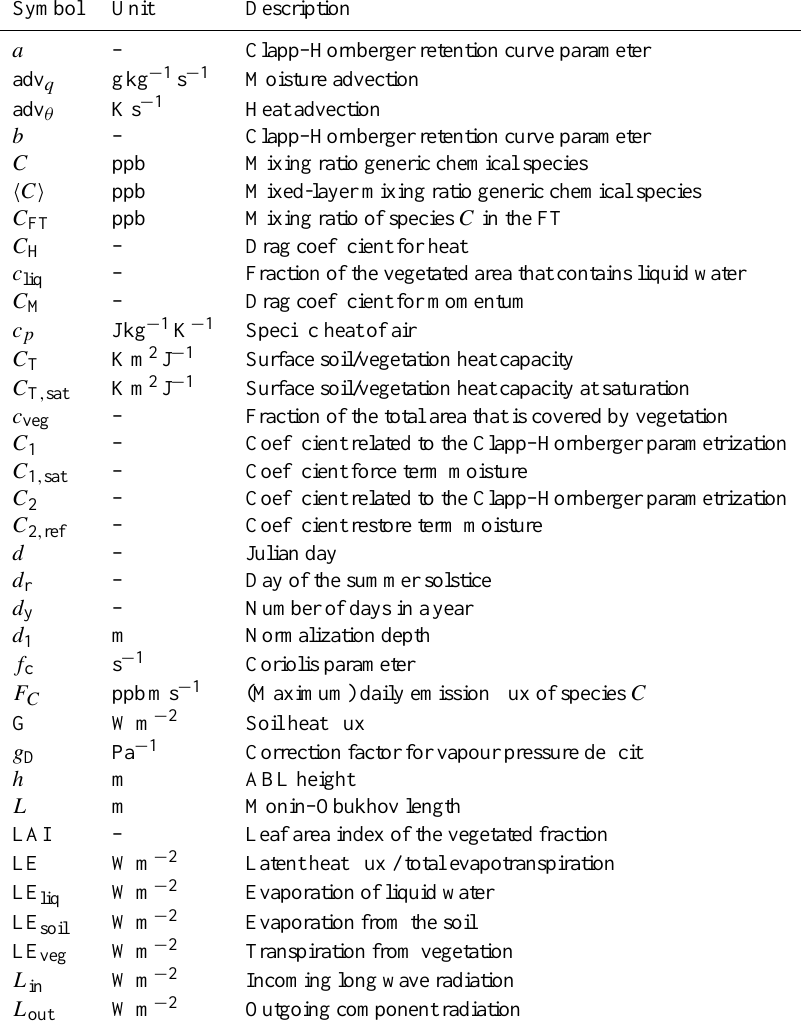
Table B2. List of variables and constants used in this work.